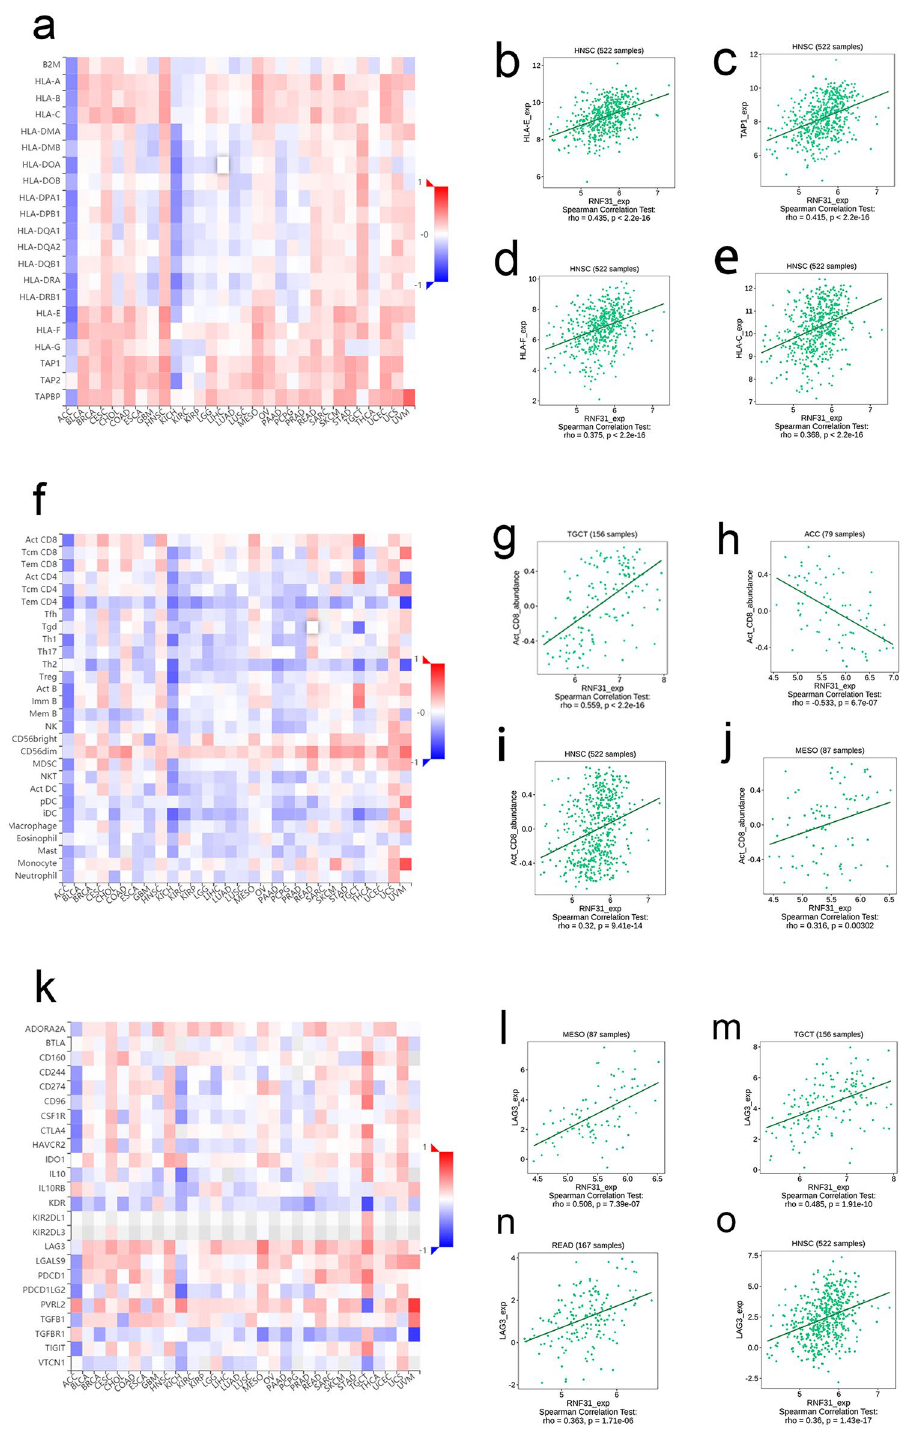
Figure 2. Relationship of RNF31 expression with major histocompatibility complex (MHC) molecules, tumor infiltrating lymphocytes (TILs) abundances and immunosuppressive molecules expression in human cancers. ( a ) Correlation of RNF31 and MHCs across human cancers. ( b – e ) RNF31 expression was positively correlated with HLA-E, TAP1, HLA-F and HLA-C in HNSC. ( f ) Correlation between RNF31 and TILs across human cancers. ( g – j ) RNF31 expression was related to Act CD8 in TGCT, ACC, HNSC and MESO. ( k ) Correlation between RNF31 and immunosuppressive molecules across human cancers. ( l – o ) RNF31 expression was related to LAG3 in MESO, TGCT, READ and HNSC. exp: expression, B2M: beta2-microglobulin, HLA: human leukocyte